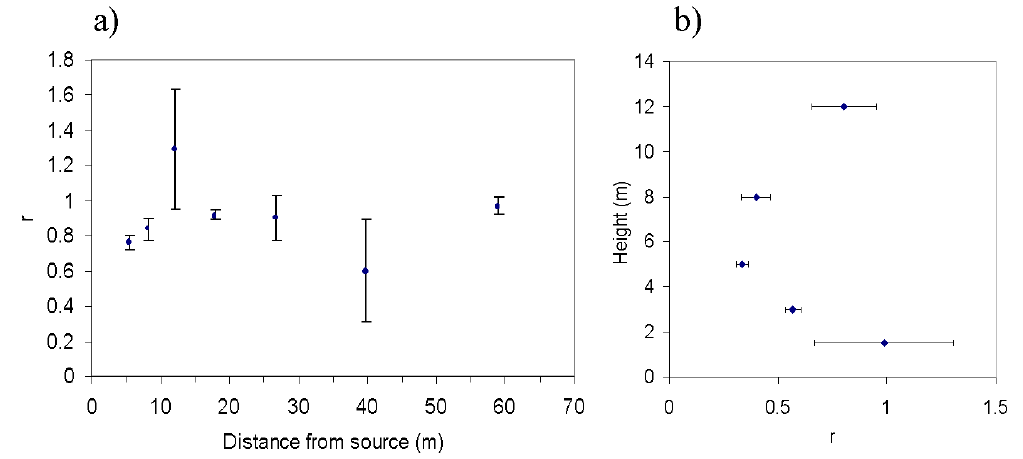
concentrations and release 6